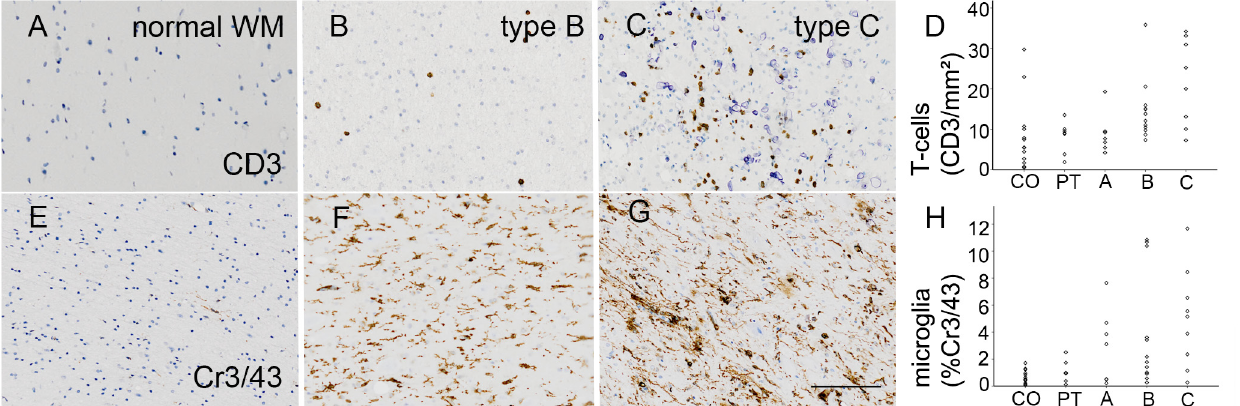
Fig 3. Inflammatory markers and vessel structure. A. Representative amount of T-cells lying in the white matter (WM) of control samples (CD3 staining). B. + C. T-cell content within type B and C tubers (CD3). D. Significant increase of CD3 positive cells in type B and C tubers compared to controls. E. Almost no microglial activation can be detected in autopsy cortex (Cr3/43 staining). F. + G. Representative WM of type B and C tubers showing an increase in microglial activation (Cr3/43). H. Quantification of the Cr3/43 positive content revealed a significant difference between controls and type B as well as C tubers. Scale bar in g = 100 μ m and applies also to a , b , c , e , f and g . CO = control; PT = perituberal cortex .